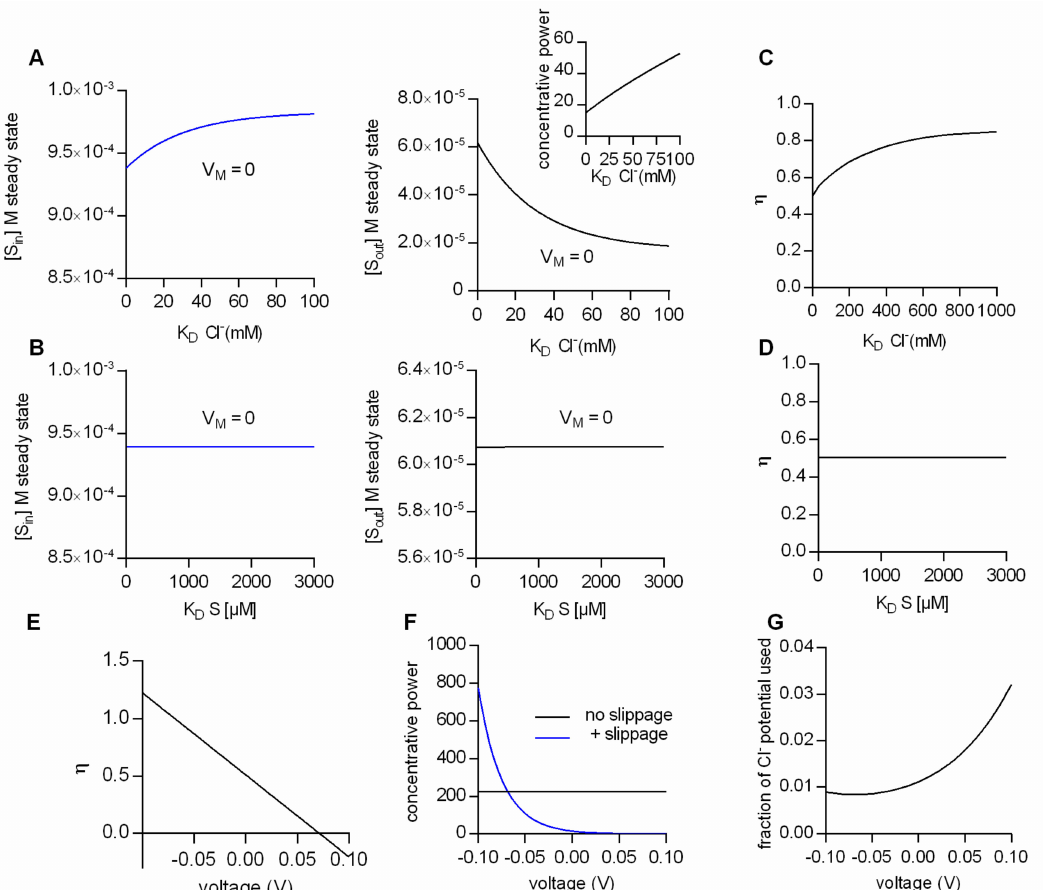
Figure 3. Impact of transporter kinetics on substrate concentrations at steady state at low conversion e ffi ciencies. The simulated data in ( A – F ) are all obtained from the model displayed in Figure 2E. ( A ) Intra- and extracellular substrate concentrations at steady state as a function of the K D for Cl − (S in is shown in the left and S out in the right panel). V M in the simulation was set to 0 mV. ( B ) Intra- and extracellular substrate concentrations at steady state as a function of the K D for substrate, in the left and right panel, respectively. V M in the simulation was 0 mV. ( C ) Conversion e ffi ciencies ( η ) at 0 mV as a function of the K D for Cl − . ( D ) Conversion e ffi ciencies ( η ) at 0 mV as a function of the K D for the substrate. ( E ) Ill-defined conversion e ffi ciencies as a function of voltage. ( F ) Concentrative power as a function of voltage. Comparison between the fully-coupled model (black line-model scheme in Figure 2C) and the model with Cl − slippage (blue line-model scheme in Figure 2E). ( G ) “fraction of the Cl − potential used” (see definition in the Section 3 “Materials and Methods”) as a function of